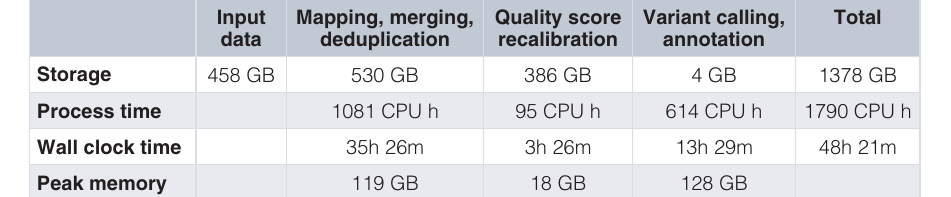
Table 2. Sarek resource usage. Resource usage during a Sarek run on a WGS 90X/90X coverage medulloblastoma dataset on a 48-threaded computer node, starting from compressed FASTQ files. The storage resources refer to result files only. The total storage including all temporary data was 3.7 TB.